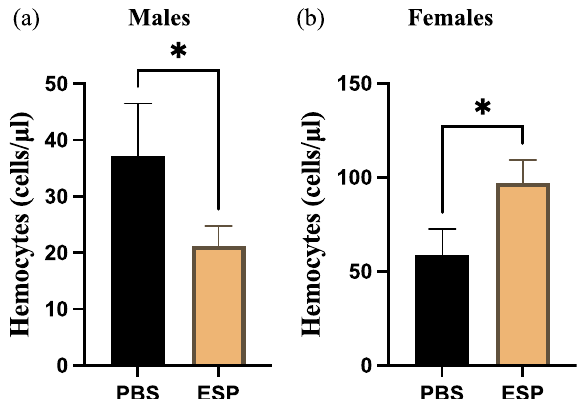
Figure 6. Steinernema-carpocapsae nematode excreted/secreted products (ESPs) alter the total number of hemocytes in Drosophila melanogaster . Oregon-R adult flies were divided into male and female groups and then injected with 3 ng of ESPs from S. carpocapsae nematodes or PBS as a control treatment. Hemocyte counts in ( a ) males and ( b ) females were evaluated three hours post-injection (* P < 0.01; One-way